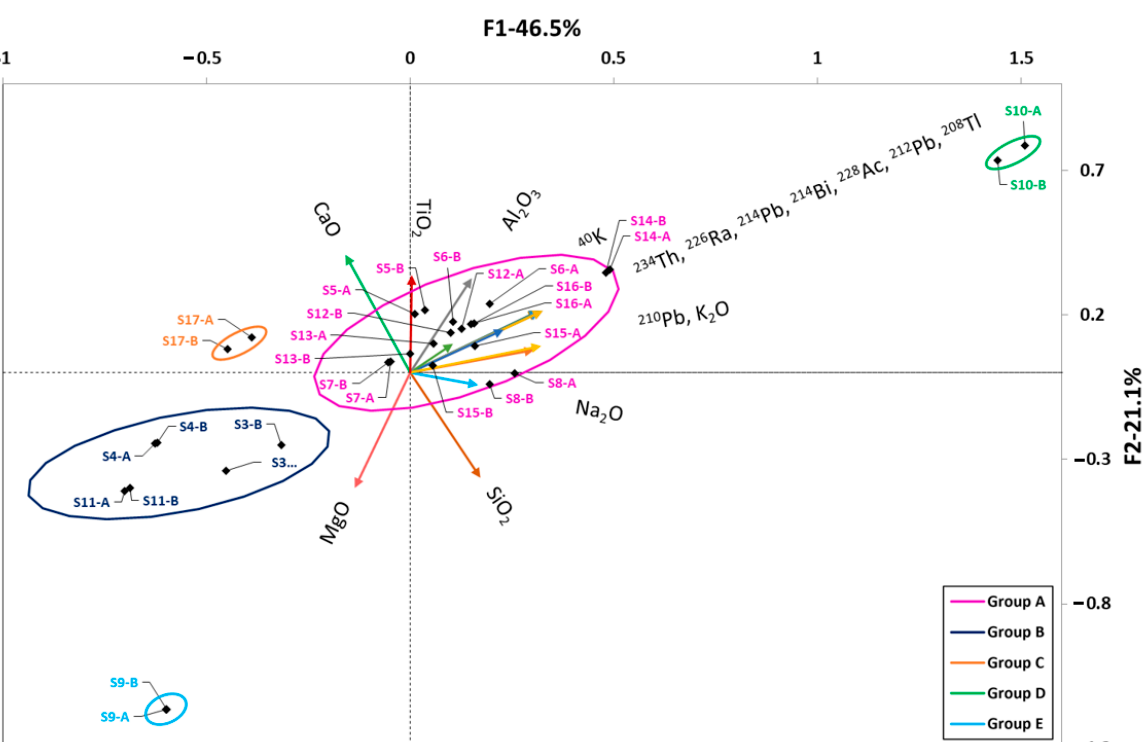
Figure 5. HJ–Biplot for the S analyzed. The variables studied were CaO, SiO 2 , MgO, K 2 O, Na 2 O, TiO 2 , Al 2 O 3 , radionuclides of the uranium and thorium series, and 40 K, represented as a vector. The KMO suitability index value obtained was 0.700. Most of the sample scores are centered on the origin of the coordinates, reflecting a lower correlation with the two factors found. Slags S9, which is strongly correlated with MgO, and S10, whose high uranium and thorium series radioisotope content distinguishes them from the rest of the samples analyzed, are the only